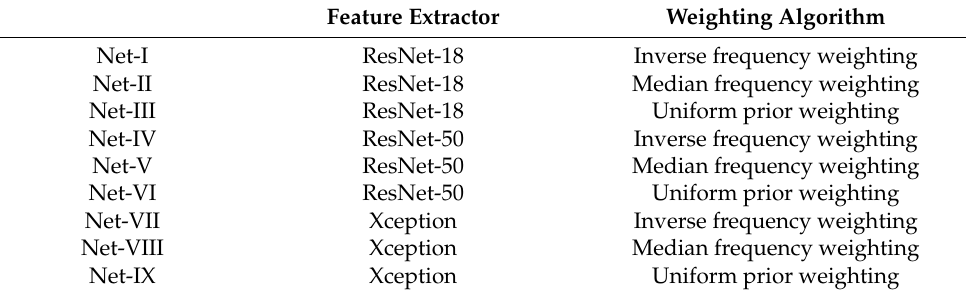
Table 7. Modifications of nine CNN